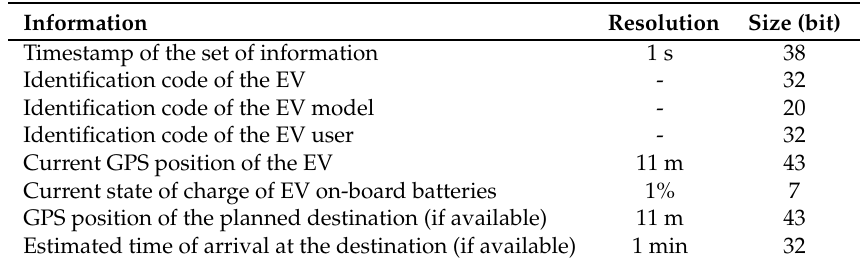
Table 2. List of information packed into each data sample transferred by the EV to the EV-MSP for EV monitoring applications. EV: Electric Vehicle, EV-MSP: EV Mobile Service